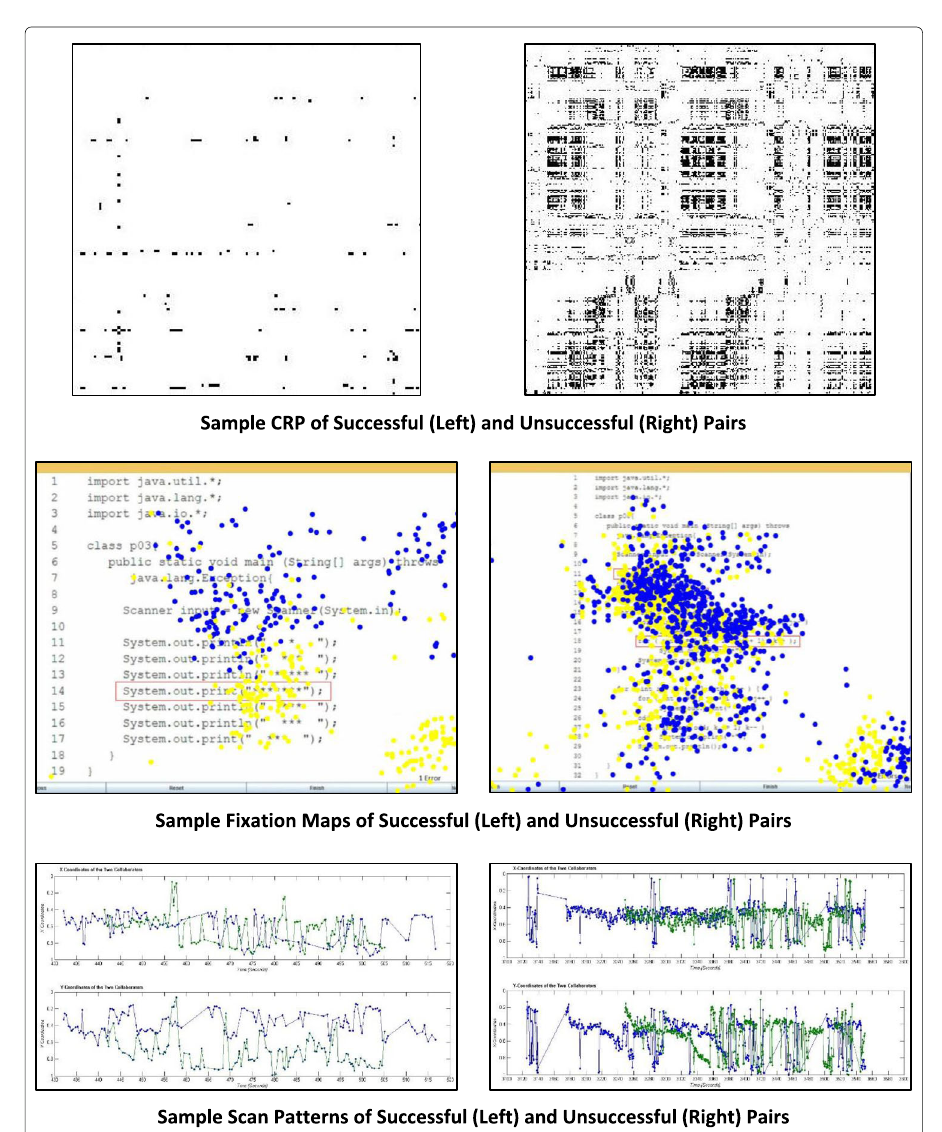
Fig. 5 Sample CRPs, fixation maps, and scan patterns of successful pairs with all low CRQA and unsuccessful pairs with all high CRQA